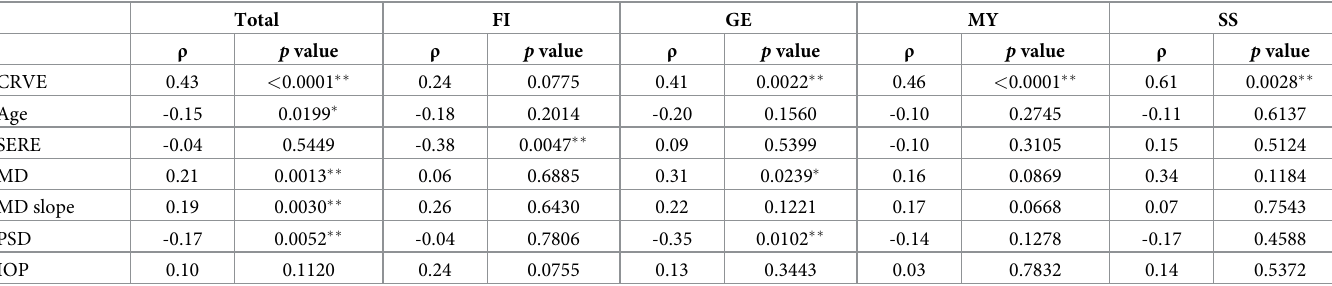
Table 3. Correlation between CRAE and demographic parameters in each optic disc appearance group. Total FI GE MY